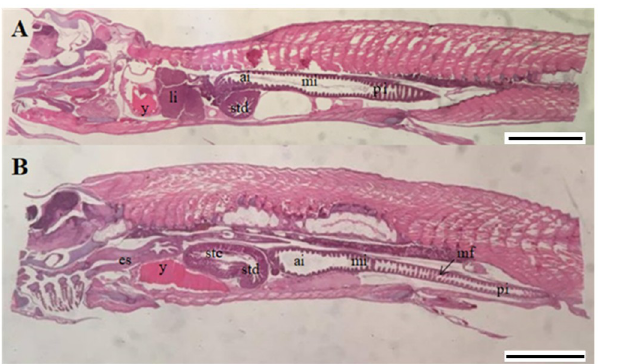
Fig 3. Longitudinal sections of the abdominal part of whole individuals of diploid and triploid Atlantic salmon at start-feeding (0 ddPSF). (A) Overview whole individual (2n). (B) Overview whole individual (3n). ai. anterior intestine; es. esophagus; li. liver; mf. mucosal folds; mi. mid intestine pi. posterior intestine; stc. stomach cardiac; std. stomach posterior; y. yolk sac. Scale. A-B. 1 mm.